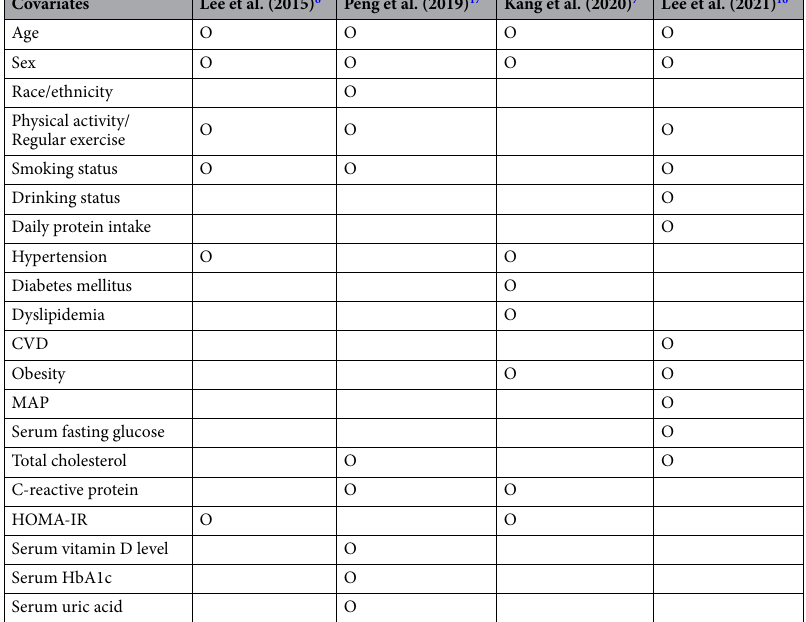
Table 1. Covariates used for the multivariate model in previous studies. CVD cardiovascular disease, MAP mean arterial pressure, HOMA-IR homeostatic model assessment for insulin